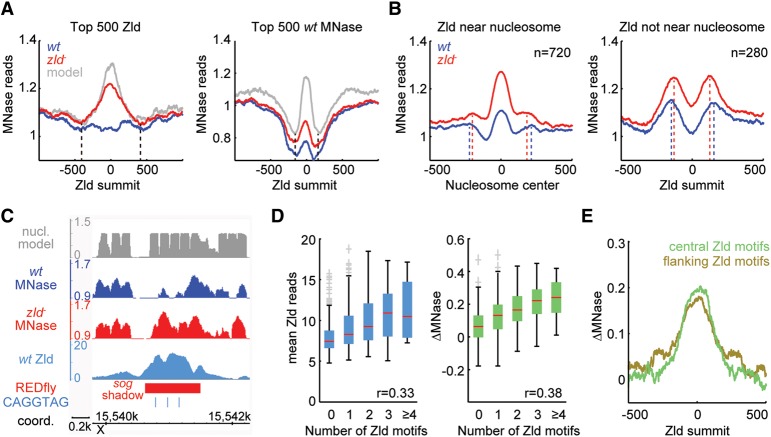
The effect of Zld on nucleosome occupancy is predominantly local. (A) Metaprofiles of nucleosome occupancy for the top 500 non-TSS Zld-bound regions as in Figure 3B, which are enriched for early enhancers (left), and the top 500 wt MNase regions (the most open regions) as in Figure 3C (right). For both plots, normalized MNase reads for wt (blue) and zld− (red), as well as the predicted nucleosome occupancy (gray) (Xi et al. 2010), were aligned to the Zld summits. Note the difference in width of the region with high nucleosome occupancy (black vertical dashed lines), suggesting that early enhancers have extended regions of high nucleosome occupancy. (B) Nucleosome positions in zld− MNase data were identified for the top 1000 non-TSS Zld-bound regions using the nucleR package (Flores and Orozco 2011). If the Zld summit mapped within 75 bp of a nucleosome center (n = 720), the normalized MNase data for wt (blue) and zld− (red) were aligned at the center of that nearest nucleosome (left). For the remaining Zld-bound regions without a nucleosome within 75 bp (n = 280), the data were aligned at Zld summits (right). Note that in both plots, there is a notable shift for the nucleosome phasing between wt (blue) and zld− (red), indicated by dashed lines. (C) IGB views showing predicted nucleosome model (gray track), wt MNase (blue track), zld− MNase (red track), Zld binding (light blue track), REDfly enhancer (red rectangle), and CAGGTAG Zld motifs (light blue vertical lines) at the sog shadow enhancer region. (D) Box-and-whisker plots showing Zld binding (as mean ChIP reads; left) and ΔMNase (the read count difference between zld− and wt; right) for the top 1000 non-TSS Zld peaks dependent on the number of Zld motifs within 125 bp of the Zld summits. The whiskers denote the interquartile range, and gray crosses mark outliers. Note that Zld binding and ΔMNase increase approximately linearly with increasing numbers of Zld motifs. (E) Metaprofiles of ΔMNase for regions with different configurations of Zld motifs among the top 1000 non-TSS Zld peaks. Regions with only 1 Zld motif within 125 bp of the Zld summit and at least one more Zld motif within 400 bp (flanking Zld motifs group; olive) have a wider profile than those with at least 2 Zld motifs confined within 125 bp of Zld summit and no more Zld motifs within 400 bp of the Zld summit (central Zld motifs group; green). Also note that the changes in nucleosome occupancy (ΔMNase) in the central Zld motif group, where the effect of Zld is confined, are strongest within 250 bp (1–2 nucleosomes) from the Zld summit, suggesting that Zld acts predominantly local.